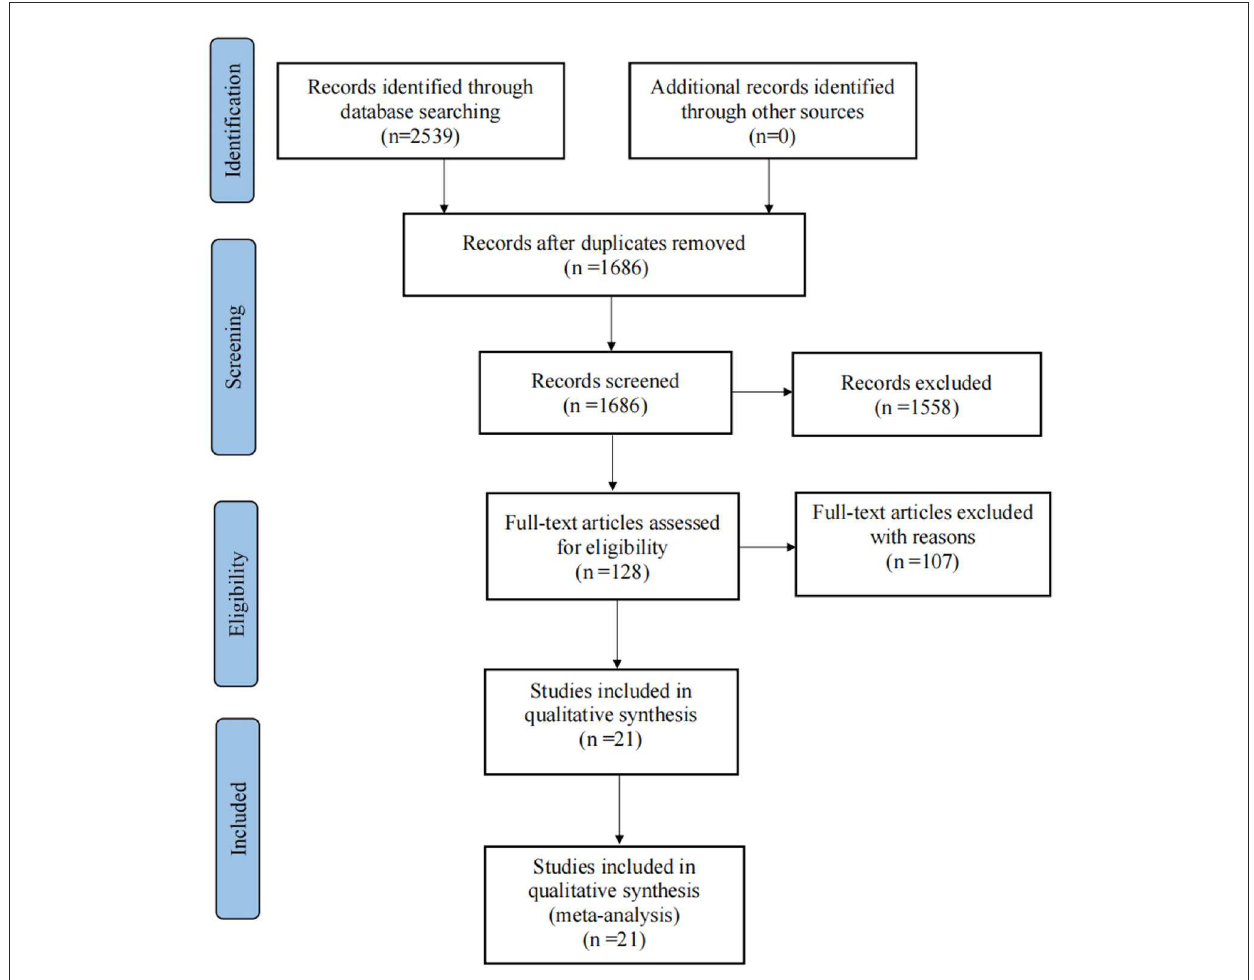
FIGURE1 Flow diagram of search and selection of studies.